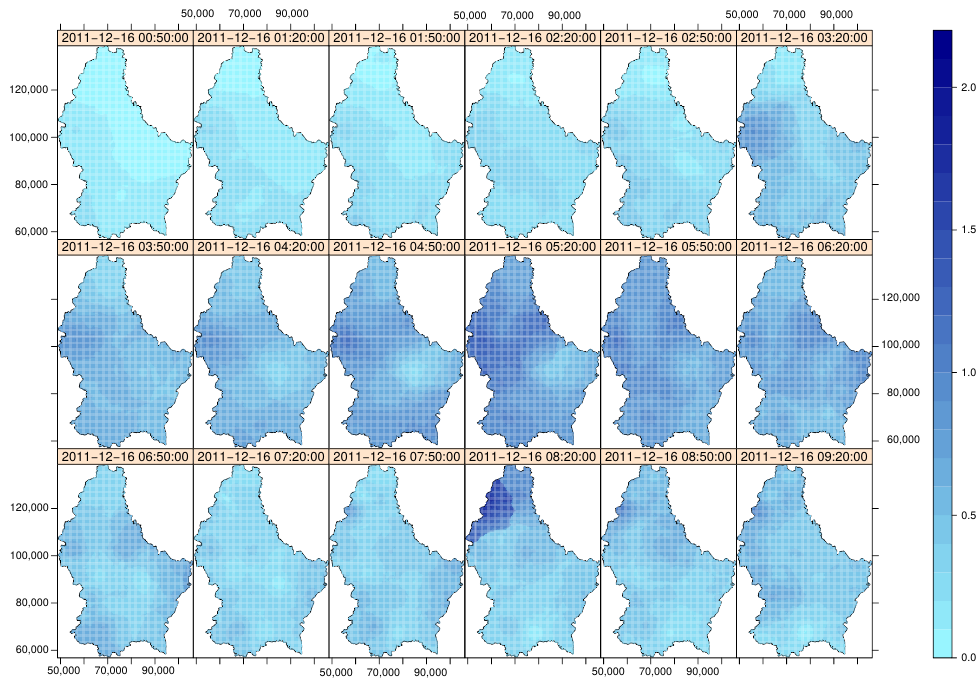
Figure 8. Prediction maps obtained with the spatio-temporal sum-metric